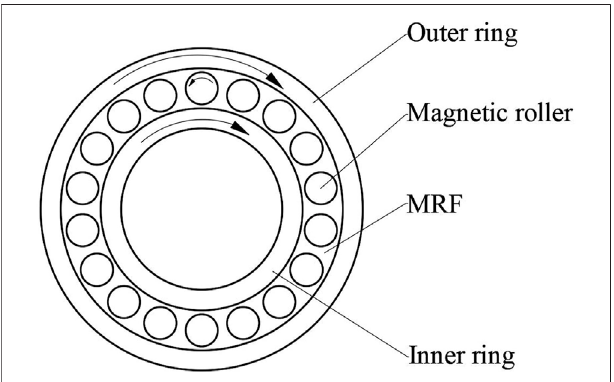
FIGURE 1 | Structural diagram of a planetary